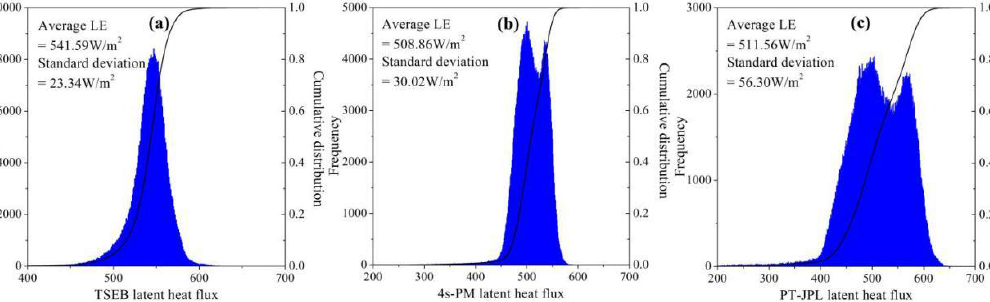
Figure 9. Histogram of the LE on 18 May of 2015 for different modes: ( a ) TSEB, ( b ) 4s-PM, and ( c ) PT- JPL.